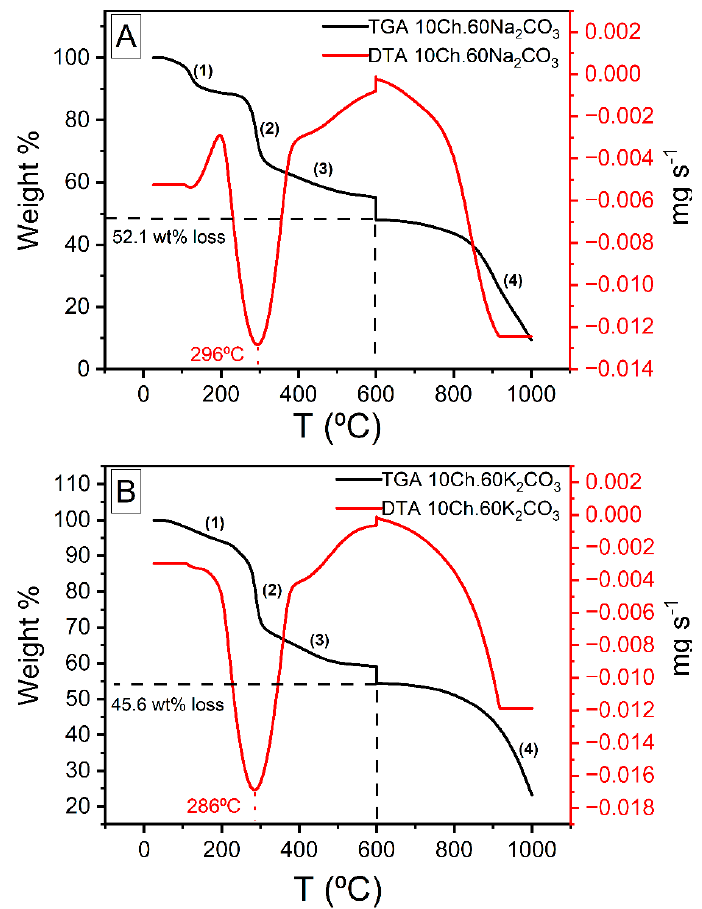
Figure 5. Thermogravimetric analysis of chitosan-based activated carbon ( A : Na 2 CO 3 activator, B : K 2 CO 3 activator) performed under nitrogen environment. The break at 600 ◦ C was carried out intentionally to simulate the experimental process of the